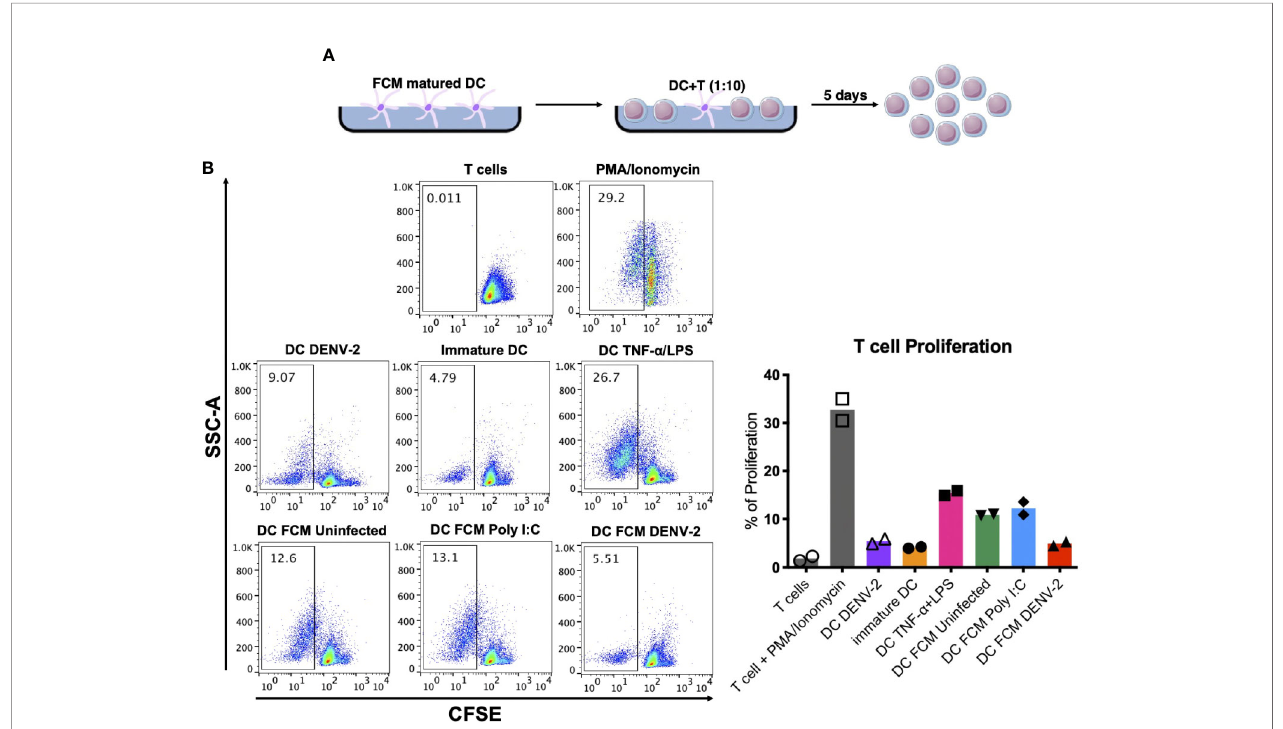
FIGURE 4 | Dendritic cells matured by fi broblast soluble mediators fail to induce T cell proliferation. (A) Schematic representation of experimental conditions. (B) Representative dot plot of a CFSE assay where T cell proliferation was observed. Analysis of the T cell proliferation percentage by fi broblast matured DC for two different donors of each donor. ns, no signi fi